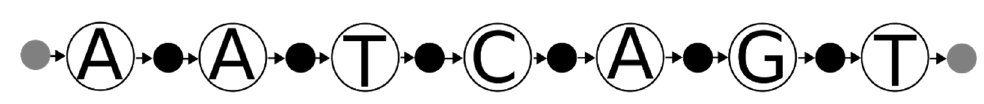
Figure 5. A reference sequence with epsilon nodes (black circles) added between each base (as well as terminal epsilon nodes, in gray, added to denote the start and end).